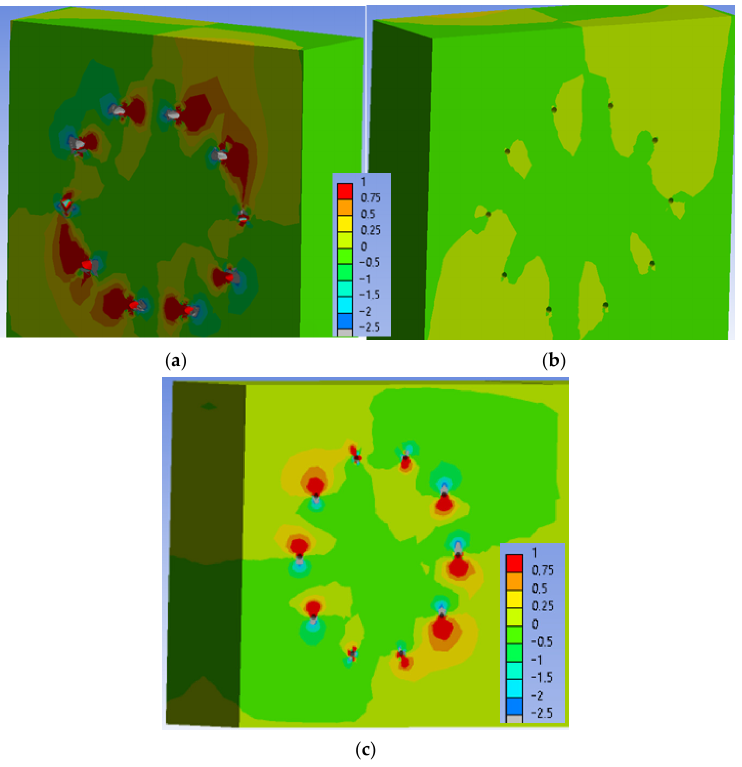
Figure 27. Tensile stress perpendicular to the grain [MPa] at 60% ULS, Experiment B: ( a ) inner side of the stand; ( b ) outer side of the stand; ( c ) rung. Figure 28 shows the normal stress perpendicular to the grain in the individual ele ‐ ments of the connection at a load level of 80% ULS. The maximum tensile stress perpen ‐ dicular to the grain (1 MPa) is also concentrated mainly near the holes at this load level. The stress in the critical area of the connection (marked in Figure 28c) increased to values of 0.25–0.50 MPa in very small range.